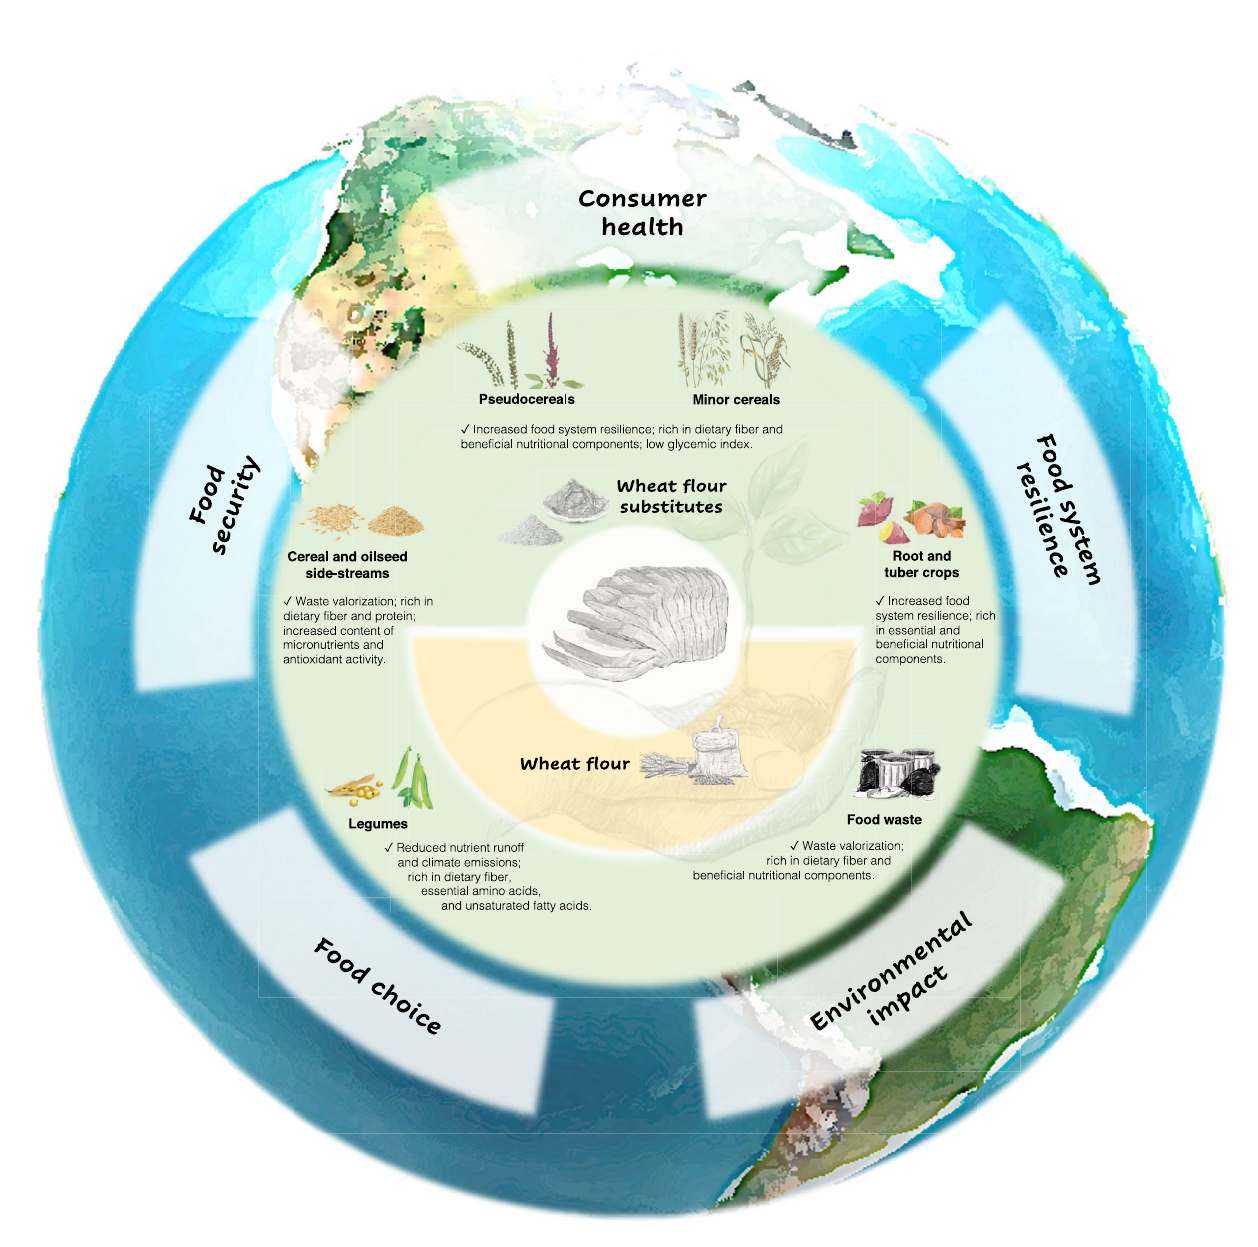
Fig. 3 Overview of wheat fl our substitutes in relation to sustainable bread